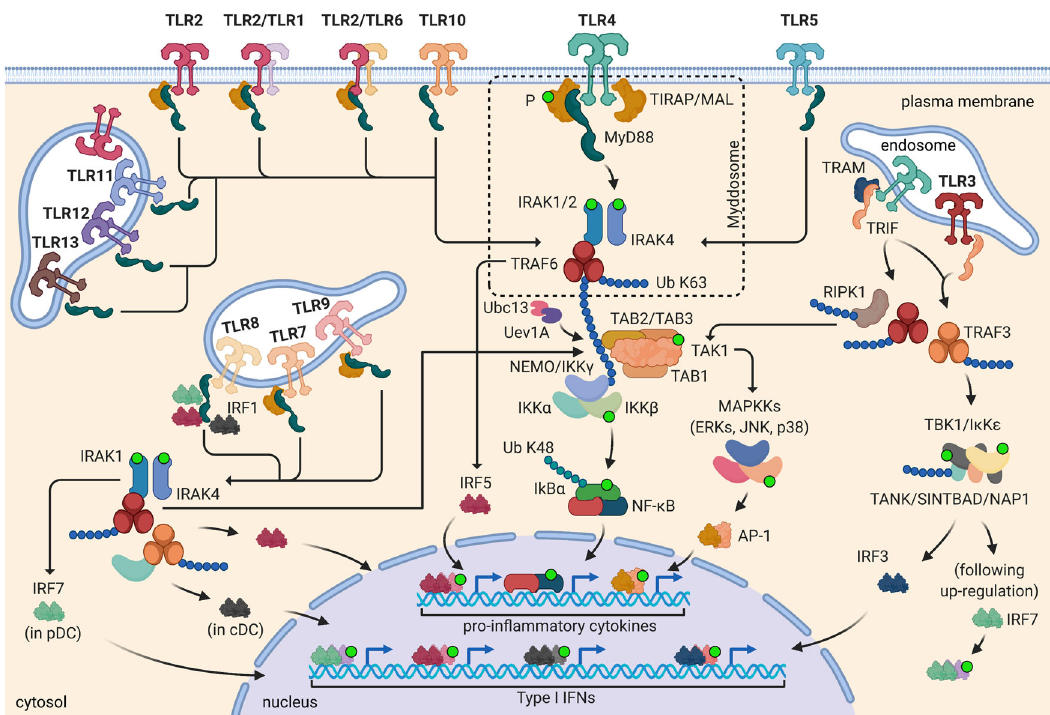
Fig. 2 Schematic overview of TLR signal transduction. Within myddosome, the C-terminal TIR domain of MyD88 interacts with TIR domains of TLRs and TIRAP/MAL (required for TLR2, TLR4, TLR7, and TLR9 signaling), whereas the N-terminal death domain (DD) recruits by homotypic interactions IRAK4, which in turn activates IRAK1 and IRAK2. These serine/threonine kinases promote both auto-phosphorylation and trans- phosphorylation of IRAK members with subsequent recruitment and activation of TRAF6, which plays as an E3 ubiquitin protein